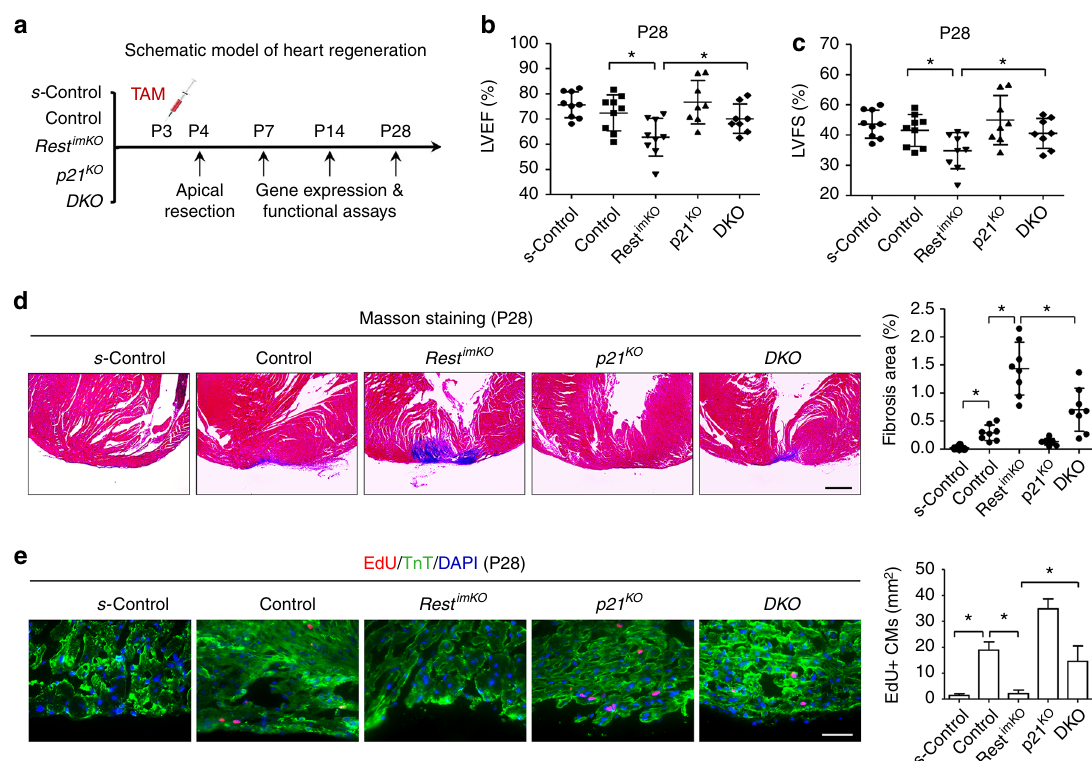
Fig. 8 REST-dependent p21 expression is required for cardiac regeneration. a Schematic diagram showing experimental procedure of cardiac apex resection (AR) on neonatal mice. b , c Echocardiography indicates that mice with control ( n = 9), single p21 knockout ( p21 KO , n = 8), and double knockout of Rest and p21 (DKO, n = 8) injured hearts have cardiac function comparable to that of the sham-operated control (s-Control, n = 9) at P28. Injured Rest single knockout ( Rest imKO , n = 9) hearts have signi fi cantly decreased left ventricular function comparable to injured control. d , e Quantitative Masson ’ s trichrome staining ( n = 8/group) ( d Scale bar = 100 µ m) and EdU assays ( n = 4/group) ( e Scale bar = 40 µ m) showing p21 inactivation reduces the cardiac fi brosis and rescues cardiomyocyte proliferation defect in the injured apex resulting from Rest deletion. Mean ± s.d. * p < 0.05 by one-way ANOVA followed by Bonferroni test. NS no signi fi